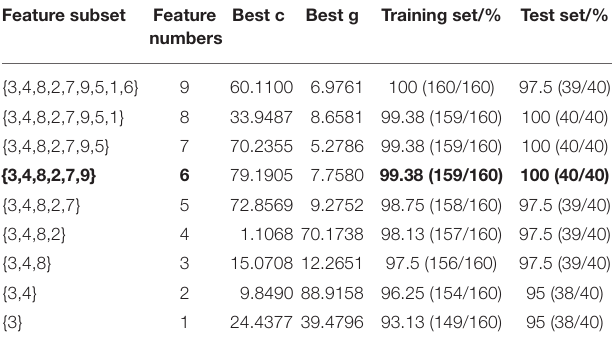
TABLE 3 | Classification accuracy of different feature subsets. Feature